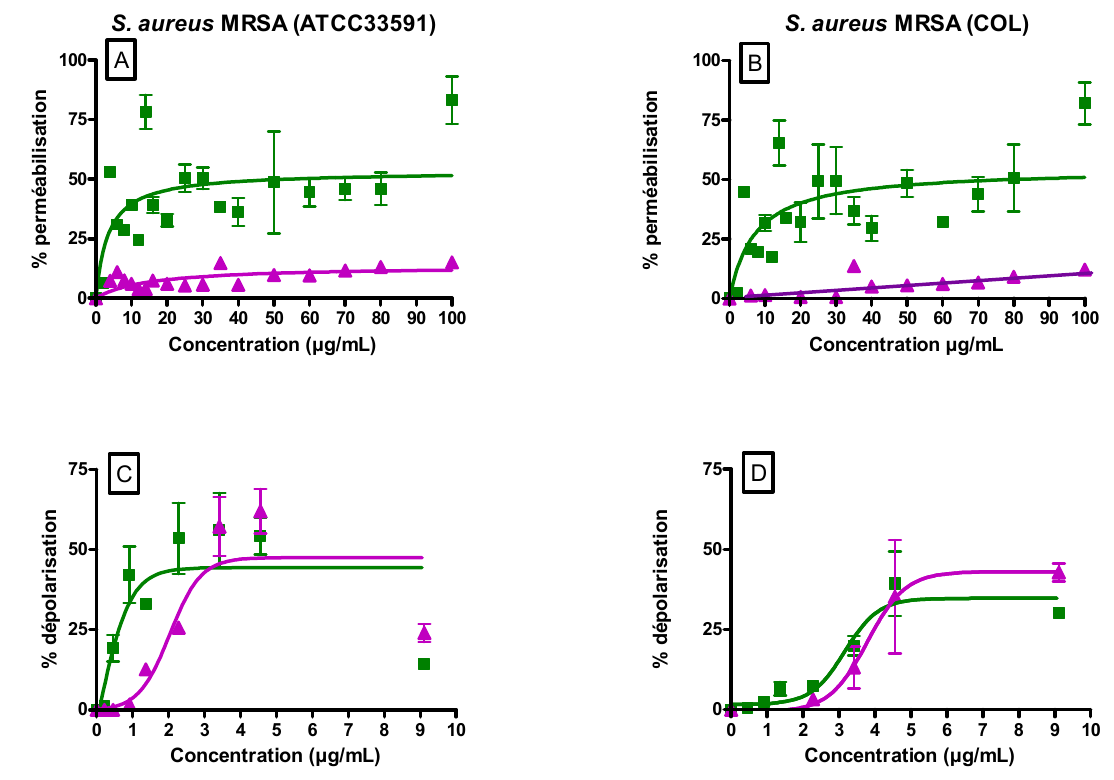
Figure 2. S. aureus MRSA (ATCC 33591 et COL) membrane permeabilization (PI fluorescence assay; A , B ) and depolarization (DiSC3(5) fluorescence; C,D ) induced by increasing concentrations of UA (Ursolic acid) ( ■ ) and OA (Oleanolic acid) ( ▲ ) expressed as a percentage of positive controls considered as 100%: alexidine (5 µM) and valinomycin (10 µM), respectively. The data represent the mean ± SEM of three independent experiments.